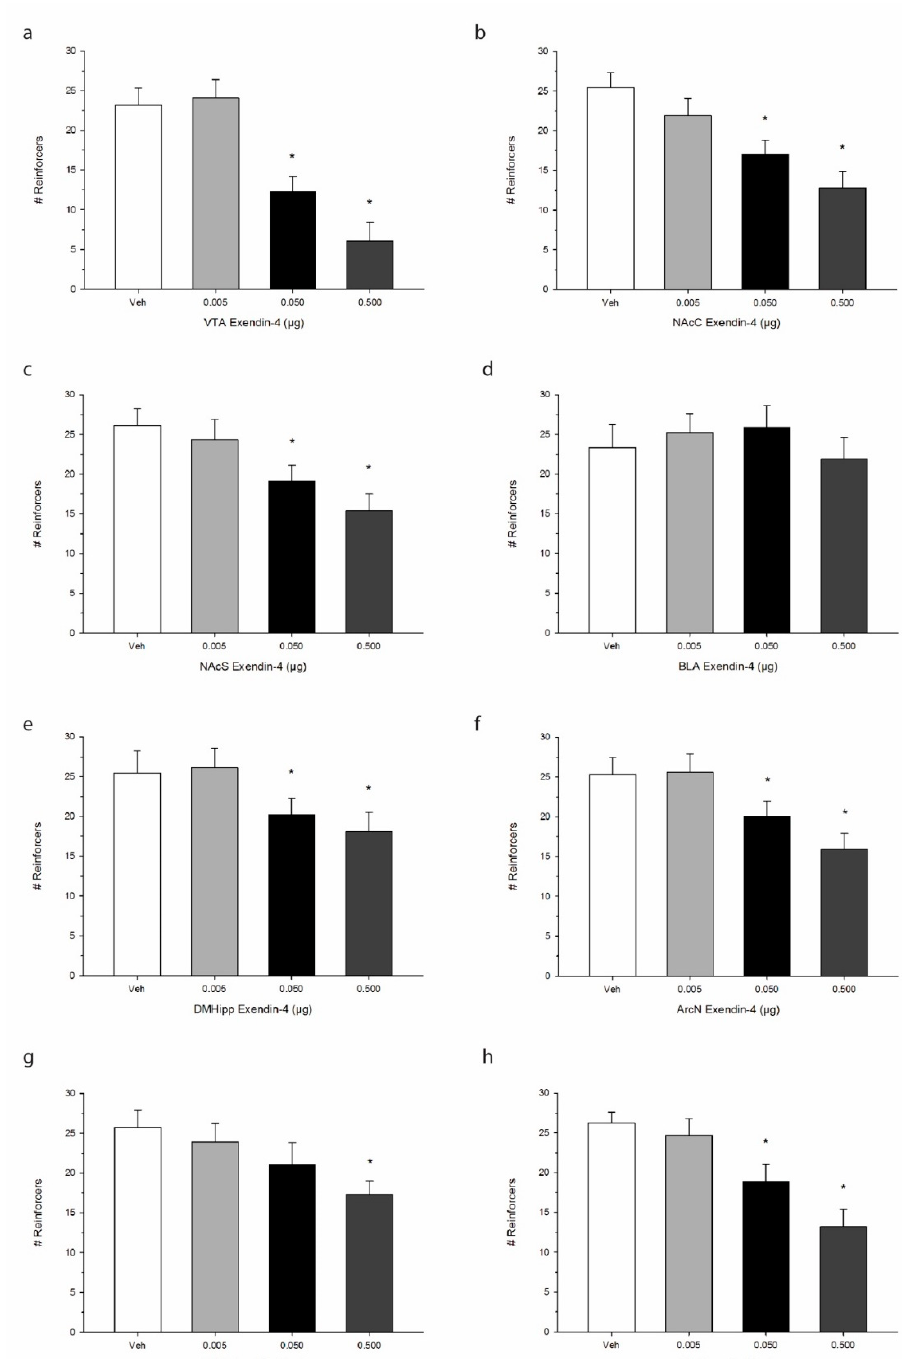
Figure 3. E ff ects of direct injections of Ex-4 on operant responding for palatable sucrose pellets. Values refer to the mean number of reinforcers obtained +/ − SEM. We observed site-specific alterations in the inhibitory e ff ect of Ex-4. Brain regions including ( a ) the ventral tegmental area (VTA), ( b ) the nucleus accumbens core (NAcC), and ( c ) the nucleus accumbens shell (NAcS) as well as ( e ) the dorsomedial hippocampus (DMHipp), ( f ) the arcuate nucleus (ArcN), ( g ) the paraventricular nucleus (PVN), and ( h ) the lateral hypothalamus (LH), exhibited an anorexigenic e ff ect of Ex-4 on sucrose consumption. Operant responding in ( d ) the basolateral amygdala (BLA), however, was not impacted. * p < 0.05 compared to Veh; n = 8 /